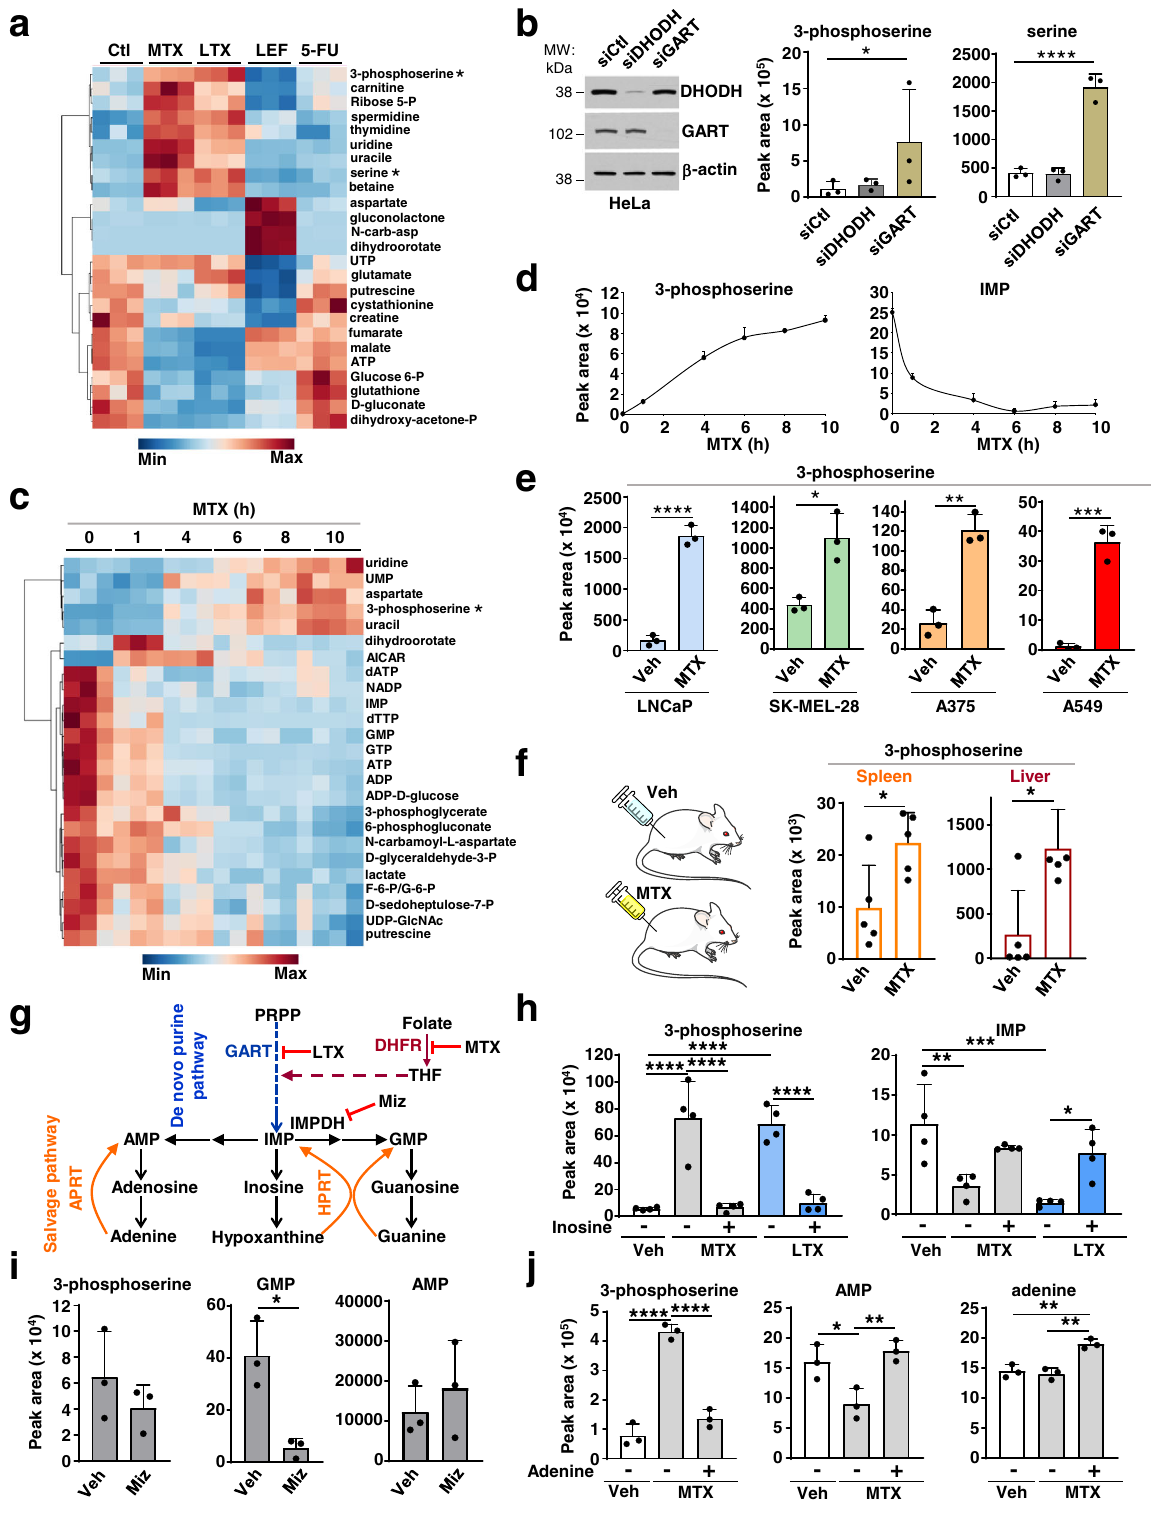
IMP and 3-PS only in wild-type cells, indicating that inosine salvage-de fi cient fi broblast cell line that lacks both of the purine conversion to purine nucleotides is essential for its acute suppressive salvage pathway enzymes, hypoxanthine phosphoribosyltransferase effects on the MTX-mediated increase in 3-PS (Supplementary (HPRT) and adenine phosphoribosyltransferase (APRT), and Fig. 3d). To test whether the increase in 3-PS and serine levels is thus cannot convert purine nucleosides or nucleobases into mediated by depletion of adenylates or guanylates, we speci fi cally nucleotides 10 . We found that while MTX treatment signi fi cantly targeted guanylate production by inhibiting inosine monopho- increased 3-PS levels in both Hprt − / − ; Aprt − / − cells (A9) and their wild-type counterparts (CCL1), exogenous inosine restored both sphate dehydrogenase (IMPDH), the rate-limiting step in de novo NATURE COMMUNICATIONS| (2022) 13:2698